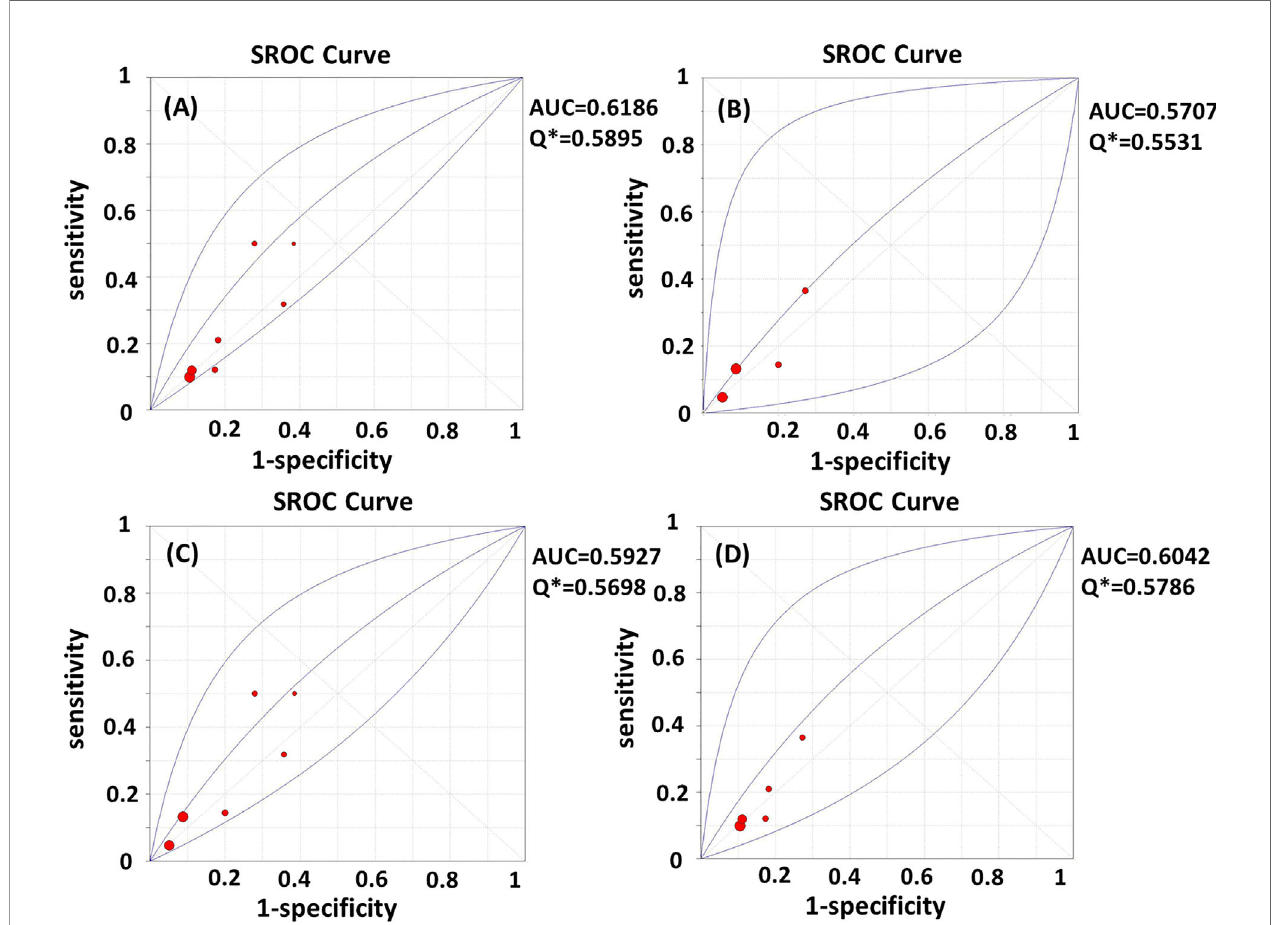
FIGURE 3 | (A – D) SROC curves of AMH in the prediction of spontaneous clinical in (A) prospective subgroup; (B) non-prospective subgroup; (C) subgroup with risk factors for infertility; (D) subgroup without risk factors for infertility. AUC, area under the summary receiver operating characteristic curve; Q*, Cochran ’ s Q